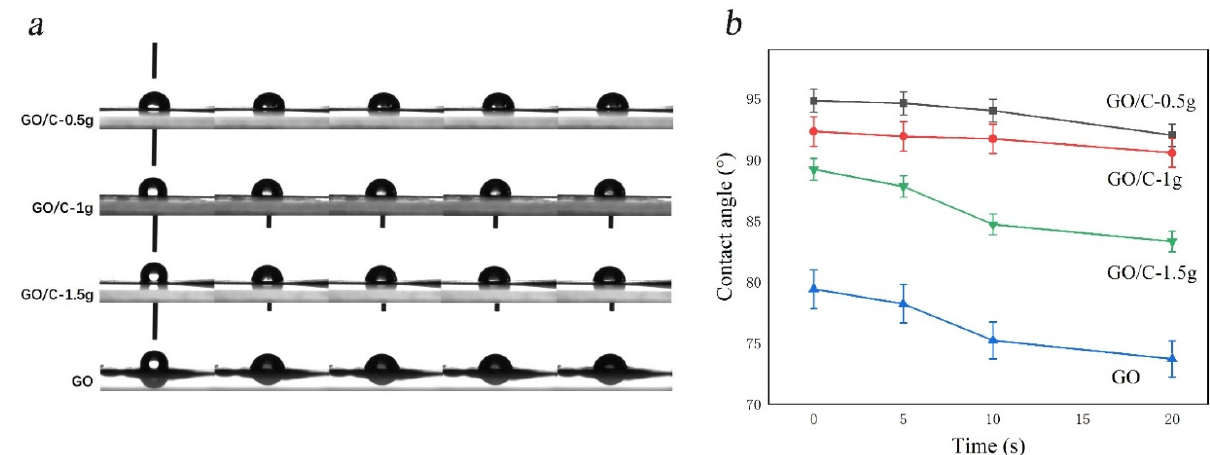
Figure 5. Alterations in water contact angles across all samples. ( a ) The contact angle test process of the samples (left to right: 1 s, 3 s, 5 s, 10 s, 20 s); ( b ) Contact angle image of hydrophobic of samples.3.5. SEM.